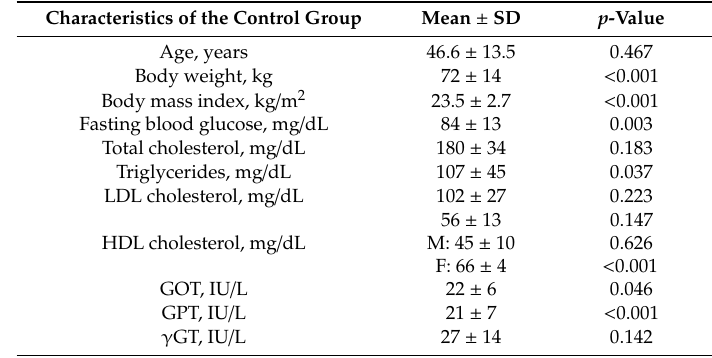
Table 2. Anthropometric and biochemical characteristics of the control group (20 subjects). p -values refer to the comparison with the patient group at